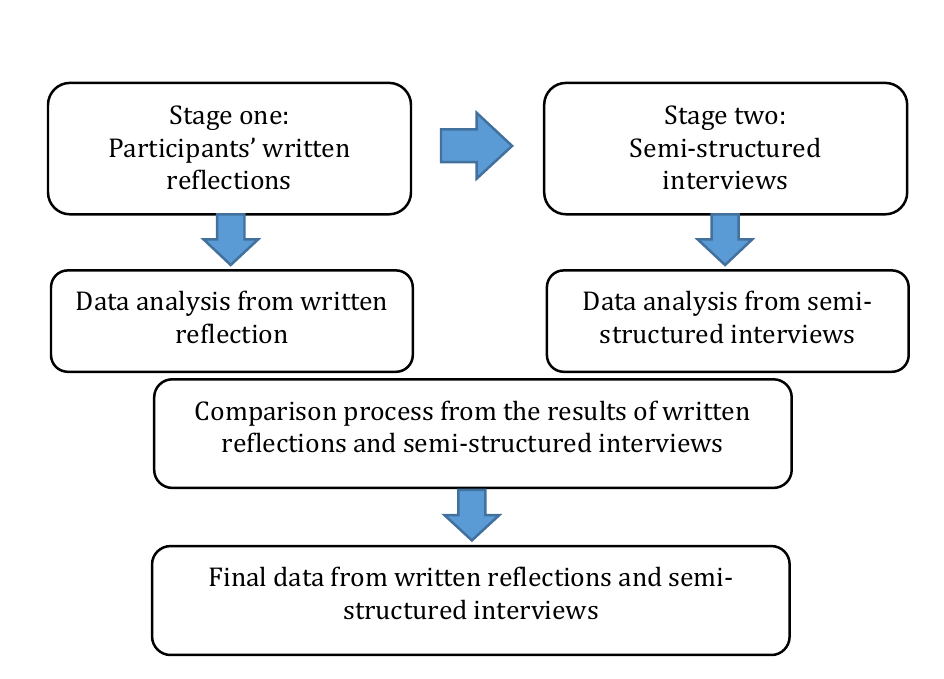
Figure 1. Procedure of data collection and